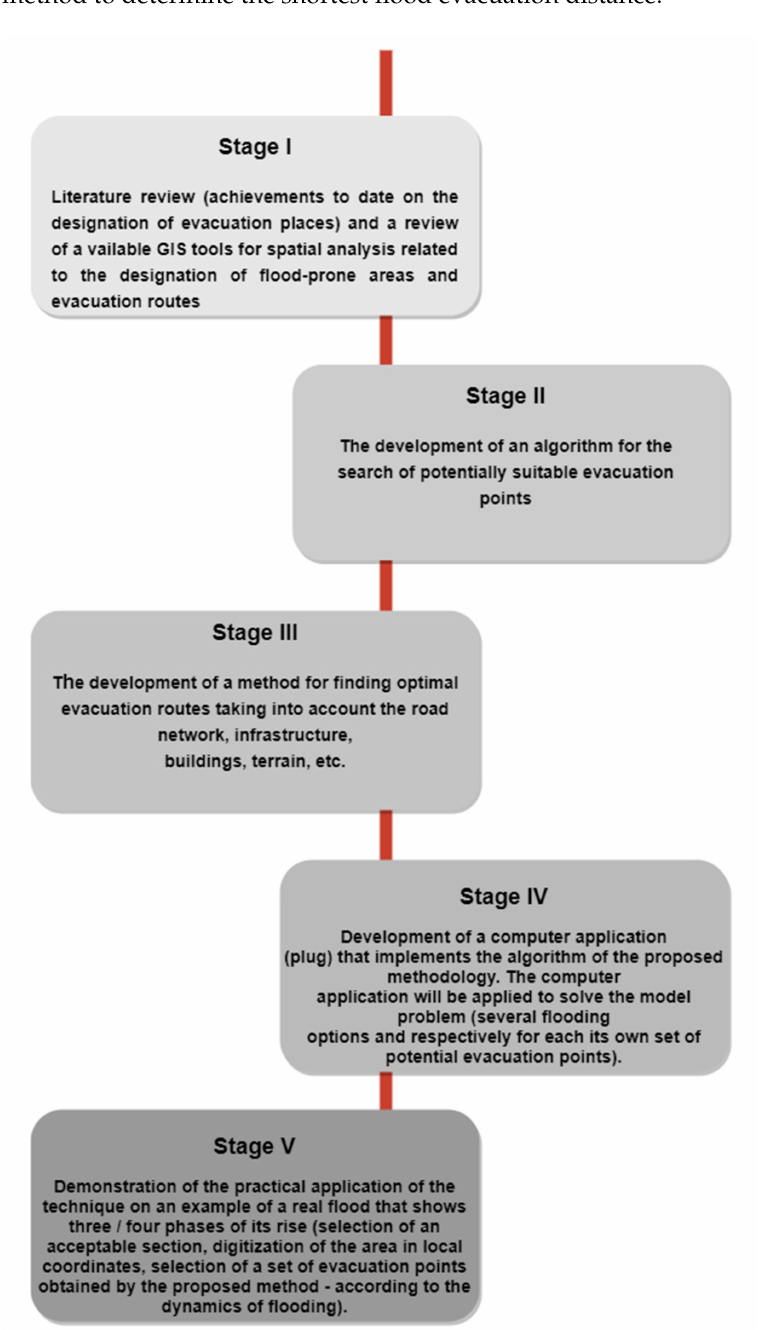
Figure 1. Methodology for finding potentially suitable evacuation points for different levels of